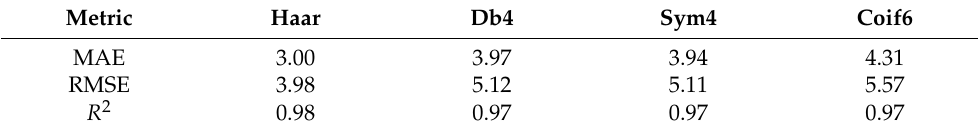
Table 1. PFP regression results for validation set of engine 1 with various mother wavelets. Metric Haar Db4 Sym4 Coif6 MAE 3.00 3.97 3.94 4.31 RMSE 3.98 5.12 5.11 5.57 R 2 0.98 0.97 0.97